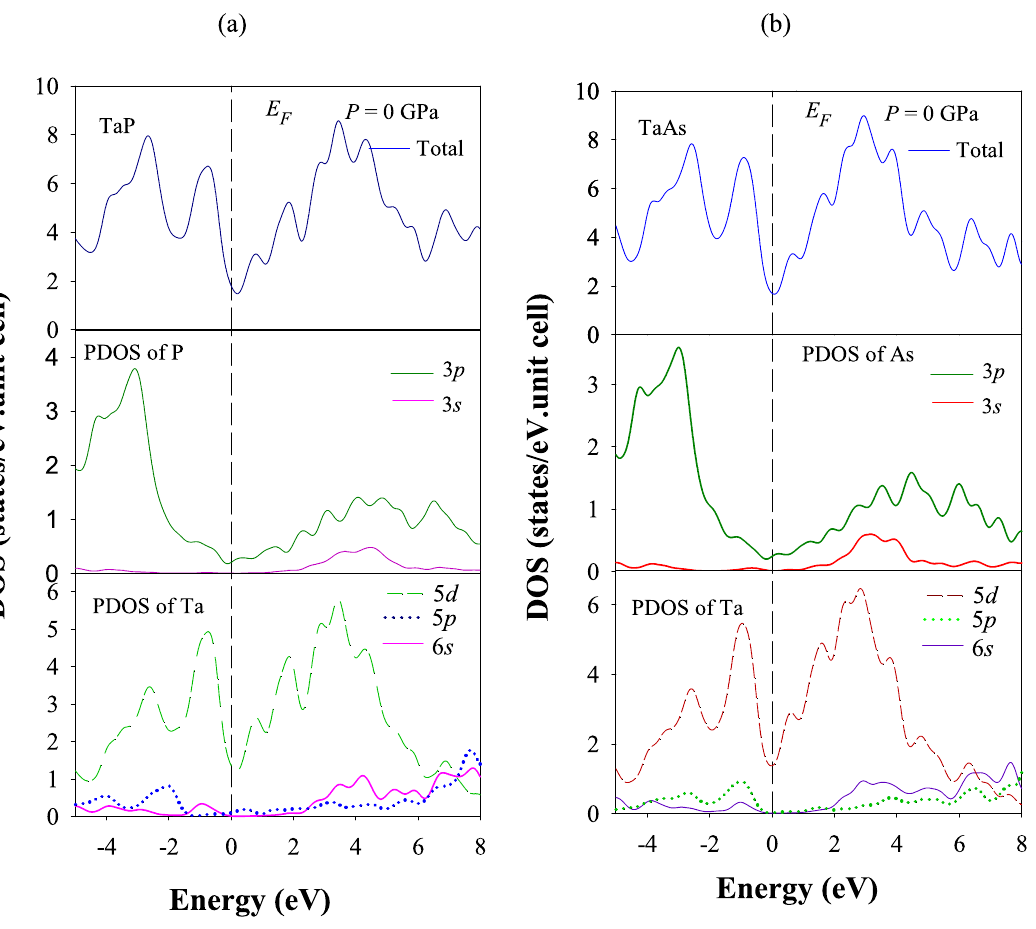
Figure 3. Total and partial electronic density of states (PDOSs and TDOSs) of ( a ) TaP and ( b ) TaAs at P = 0 The total density of states at the Fermi level for TaP and TaAs are 1.77 and 1.70 states/eV-unit cell, respectively. The electron–electron interaction parameters of TaP and TaAs are found to be 0.17 and 0.16, respectively. This repulsive Coulomb pseudopotential reduces the transition temperature, T c of superconducting compounds 110–112 . Electronic charge density distribution. To attain further insights into the bonding nature of Ta X ( X = P, As), the charge distribution around the atoms within the crystal has been investigated. We have studied electronic charge density ( e / Å 3 ) distribution within different crystal planes. Figure 4 shows the electronic charge density distribu- tion of TaP and TaAs in the (100) and (010) planes. The color scales on the right hand side of each compound’s charge density maps illustrate the total electron density. The red color indicates high charge (electron) density and blue color indicates low charge (electron) density for TaP and for TaAs, respectively. The charge density dis- tribution map shows clear signatures of covalent bonding between Ta-Ta, Ta-P and P-P atoms and Ta-Ta, Ta-As and As-As in TaP and TaAs compounds respectively. These findings agree with the Mulliken bond population analysis (“Bond population analysis” section). For both the planes, from the charge density maps of TaP and TaAs, we can see that P and As atoms have high electron density compared to Ta atoms. Ta atoms are electron deficient in both TaP and TaAs and have nearly spherical charge distribution. These features point toward some ionic contribution to the overall bonding. The charge distribution around P and As are non-spherical, which suggests directionality and covalent bonding between Ta and P atoms and Ta and As atoms, respectively. This feature is consistent with the DOS curves (Fig. 3a), which shows strong hybridization between Ta-5 d and P-3 p in TaP and Ta-5 d and As-3 p in TaAs. Charge density distribution of TaP and TaAs on different planes shows both direction and plane dependency. Thus we can say that, both TaP and TaAs have anisotropic charge density distribution. Bond population analysis. The Mulliken bond populations 113 are studied to get understanding of the bonding nature (ionic, covalent and metallic) in a compound and effective valence of atoms in the molecules present in the compound in greater depth. The Mulliken charge is related to the vibrational properties of the molecule and quantifies how the electronic structure changes under atomic displacement. It also affects dipole moment, polarizability, and charge mobility in reactions, electronic structure, and other related properties of